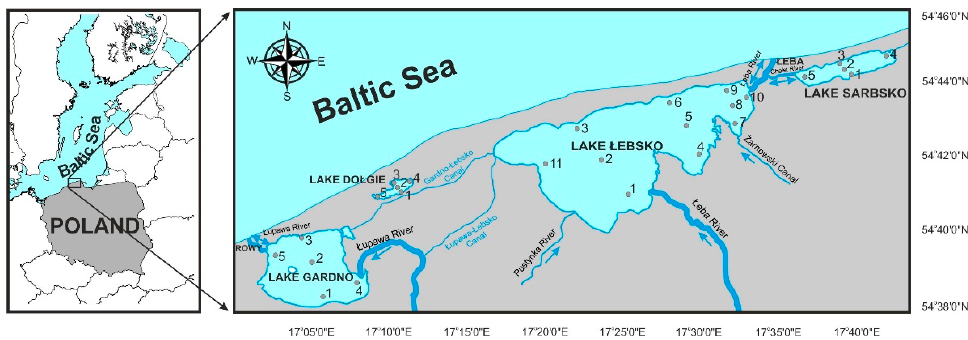
Figure 1. Locations of the studied coastal lakes of the southern Baltic Sea and sampling sites (numbers).